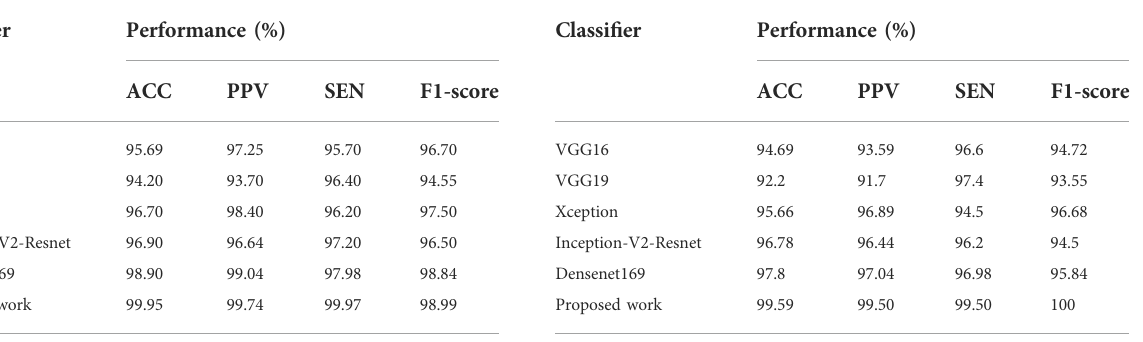
TABLE 5 Experimental results obtained with proposed model and different DL models on X-ray